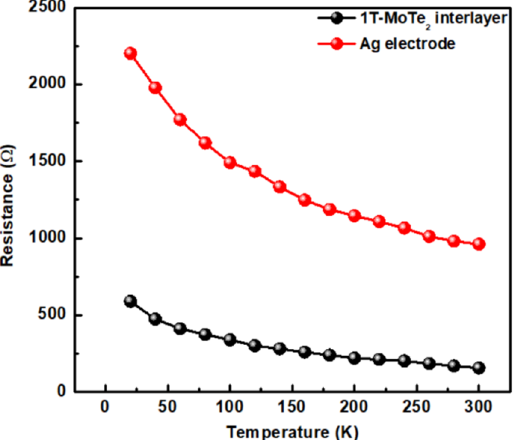
Figure 6. The resistance as a function of temperature in the range from 20 to 300 K for Ag and 1T- MoTe 2 interlayer electrode contacts of 2H-MoTe 2 .